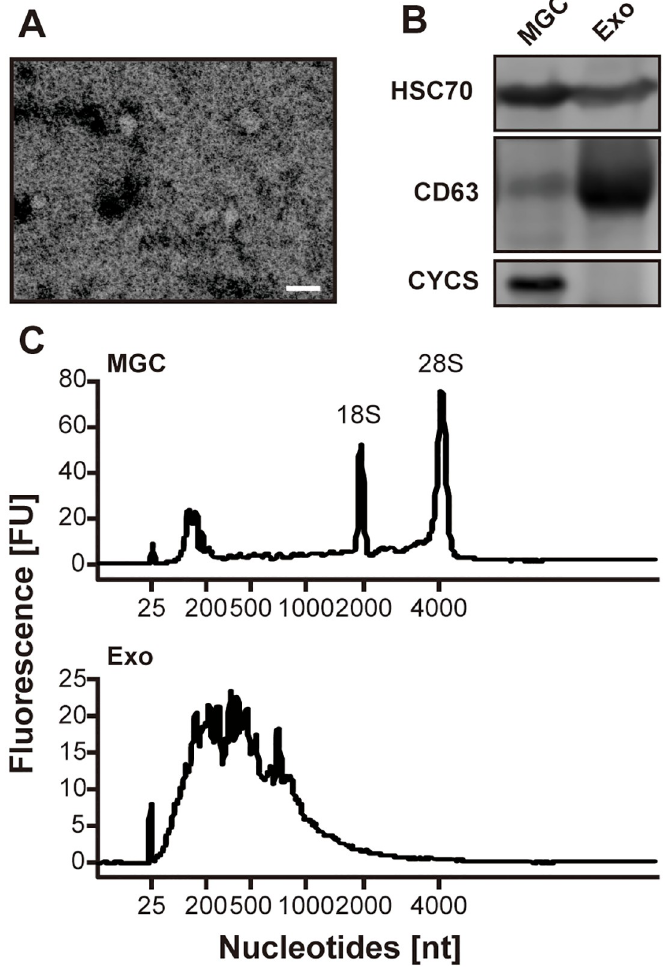
Fig 1. Detection of exosome-like vesicles in the exosomal fraction isolated from pFF. (A) Representative photograph of vesicles in the exosomal fraction isolated from pFF observed using transmission electron microscopy. The scale bar indicates 100 nm. (B) Western blotting analysis for HSC70, CD63, and CYCS. MGC, mural granulosa cell; Exo, exosomal fraction. (C) Representative electropherograms observed using bioanalyzer. FU, fluorescence intensity units; nt,